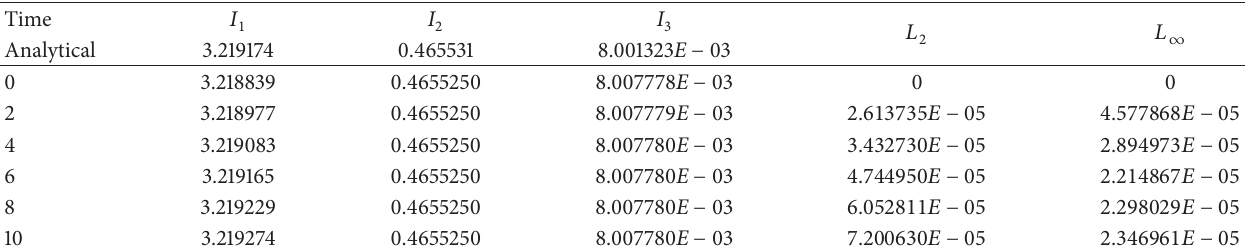
Table 2: Invariants and error norms for single solitary wave, 𝑐 = 0.05 , ℎ = 0.2 , 𝑘 = 0.2 , 𝑥 0 = 40 , and 0 ≤ 𝑥 ≤ 100 (using Runge-Kutta time discretization).